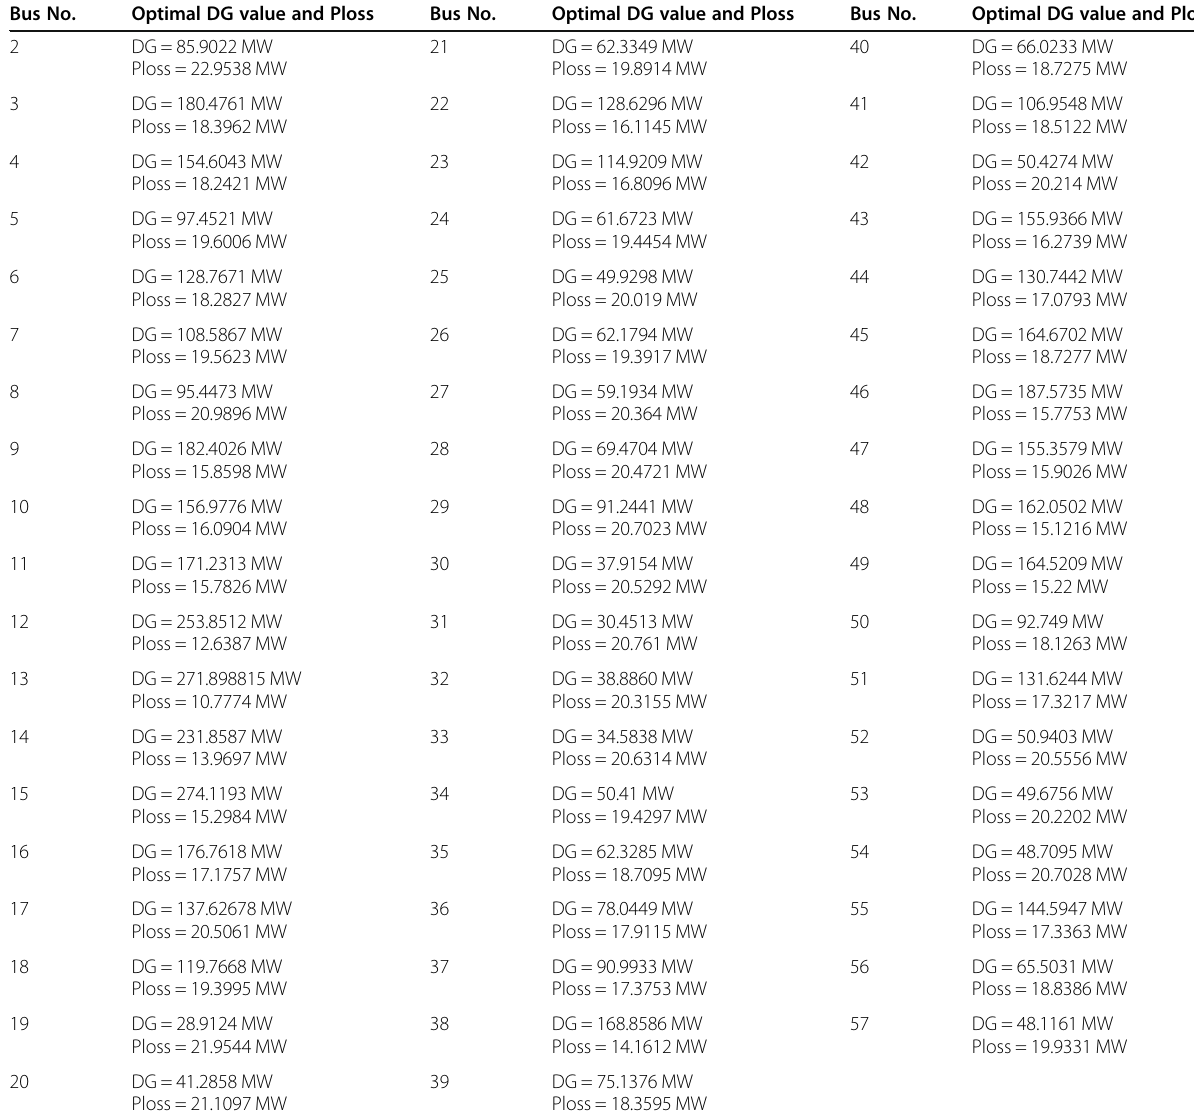
Table 19 Optimum solution for the IEEE 57 bus system with DG individually injected at each bus using the JAYA algorithm Bus No. Optimal DG value and Ploss Bus No.